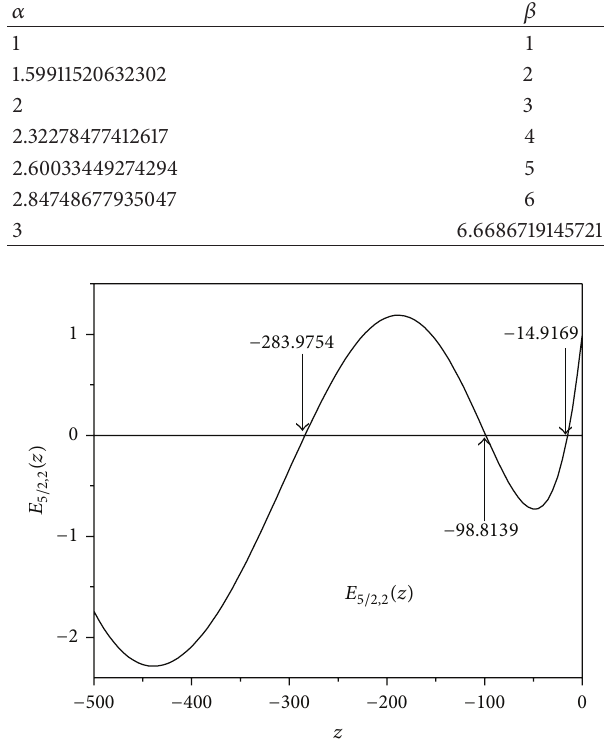
Table 3: Reference values in phase [𝑓/∞]